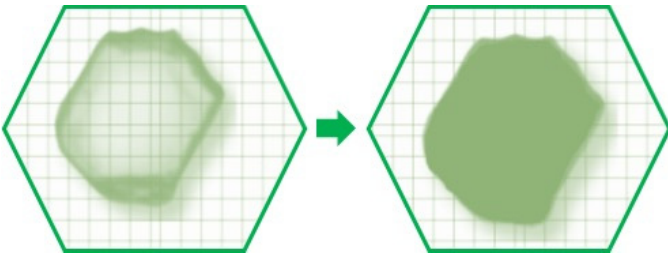
Figure 15. Image capture and analysis (modified from [141]).